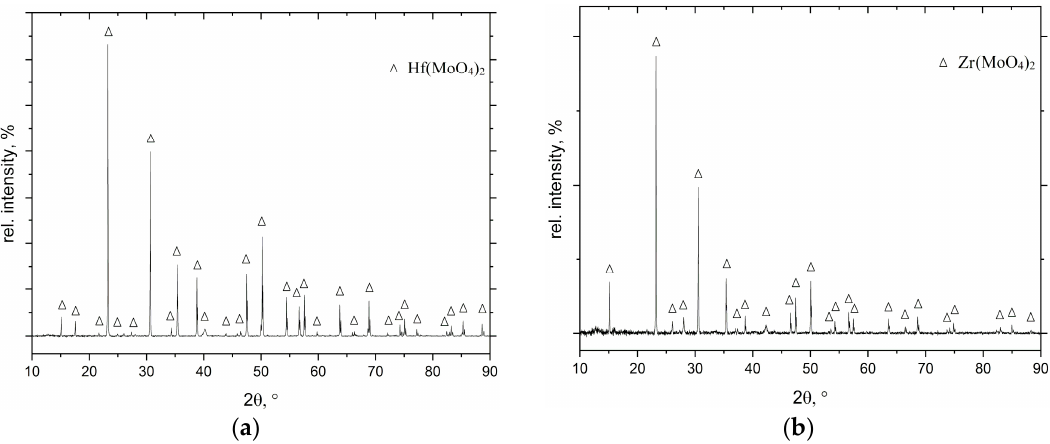
Figure 2 . X-ray diffraction patterns of ( a ) Mo-14Hf-23B and ( b ) Mo-14.8Zr-26B alloys, both after exposure to air for 10 h at 800 °C.